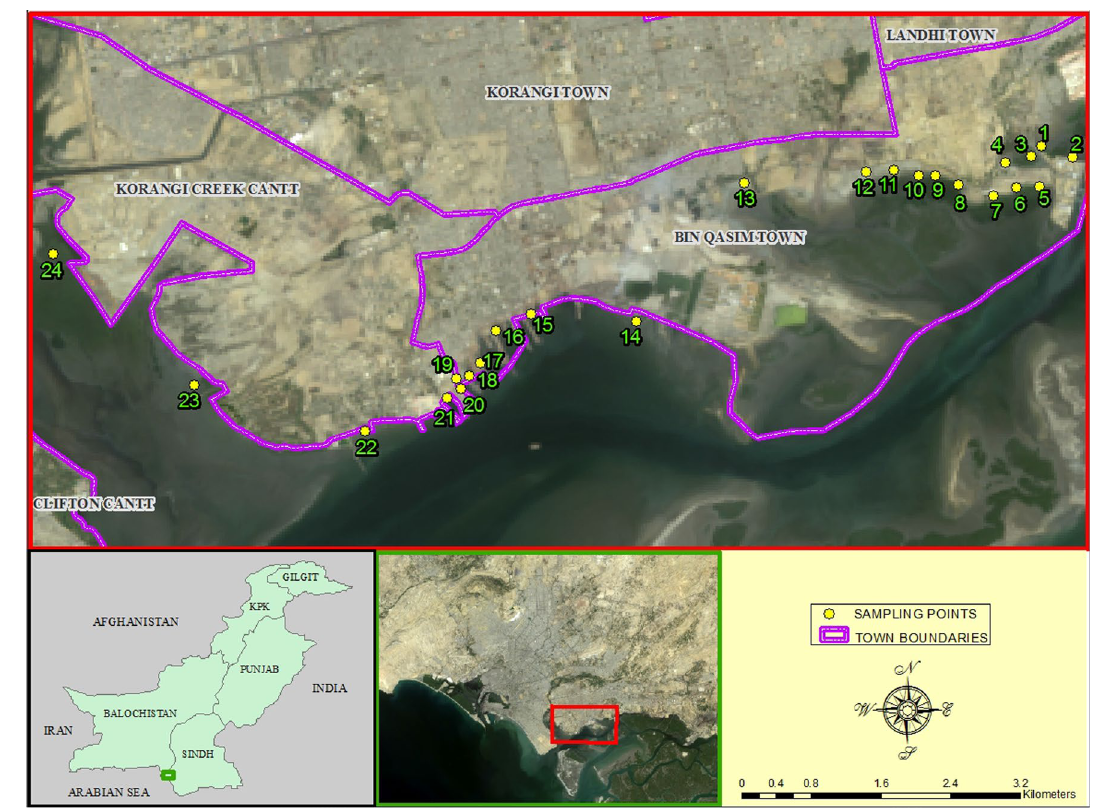
Fig. 1 Sampling points of Korangi